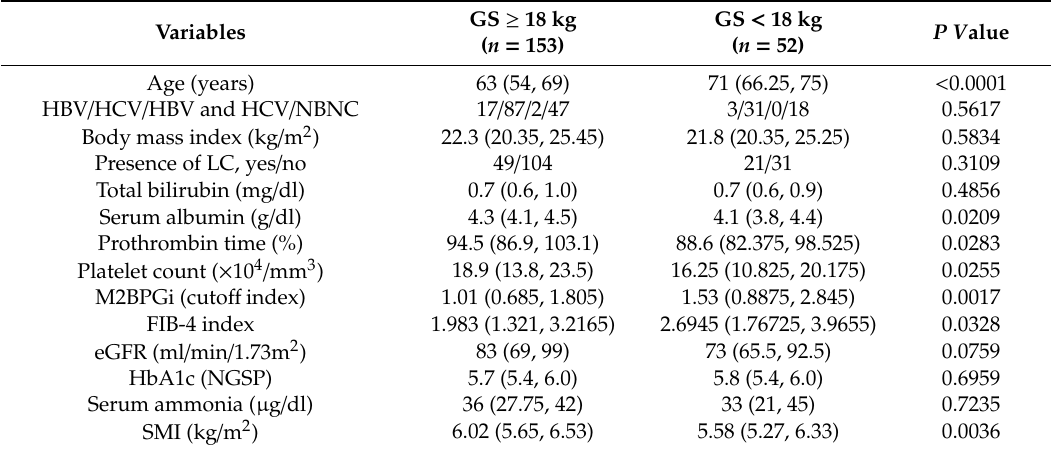
Table 4. Univariate analyses of factors linked to grip strength (GS) < 18 kg in